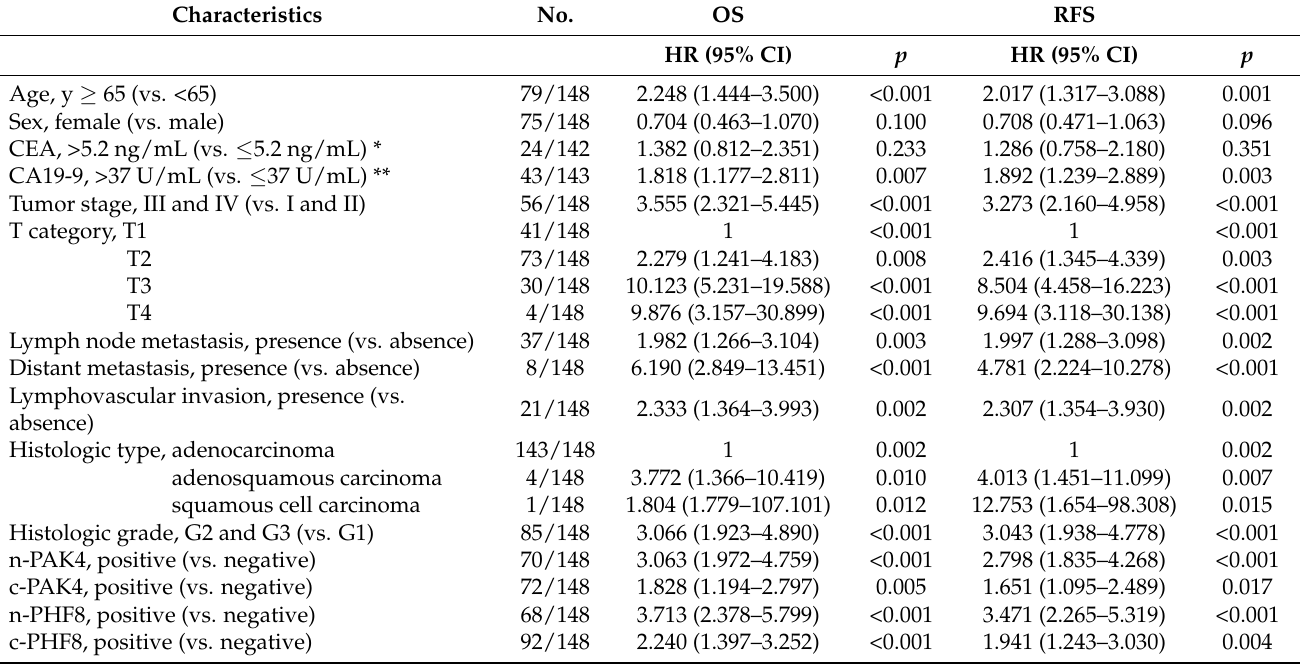
Table 2. Univariate Cox regression analysis in